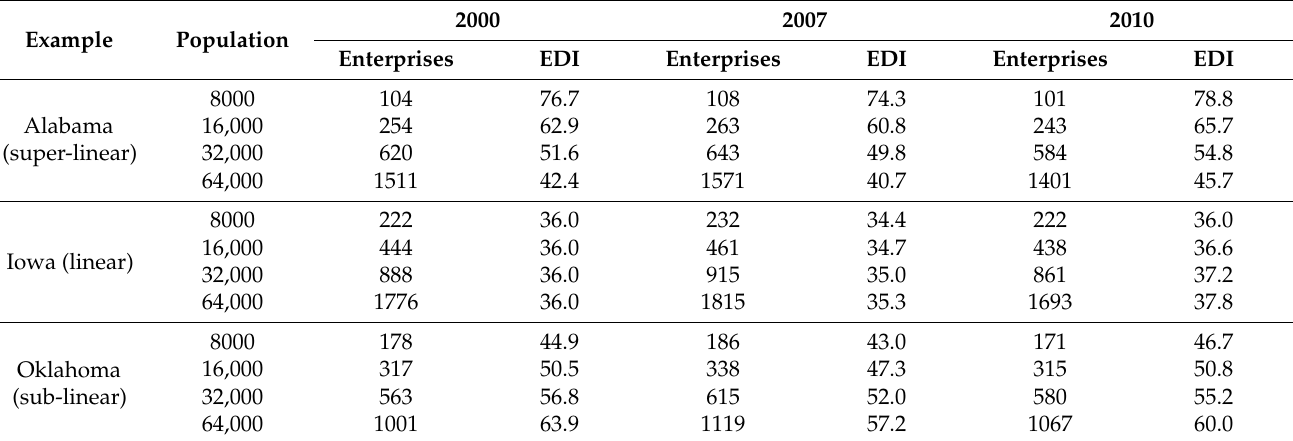
Table 7. Examples of the 2000, 2007, and 2010 dynamics of the enterprise dependency indices of county groupings with power laws with super-linear, linear, or sub-linear